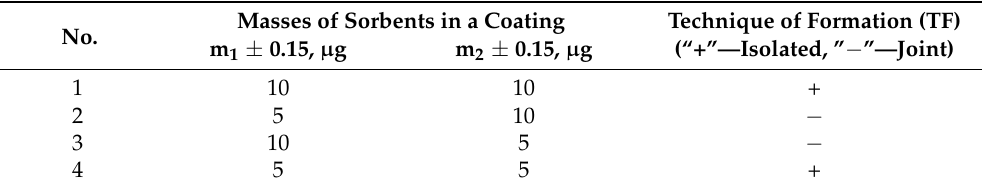
Table 4. Design matrix for the choice of masses of sorbents and the technique of forming a poly- composite